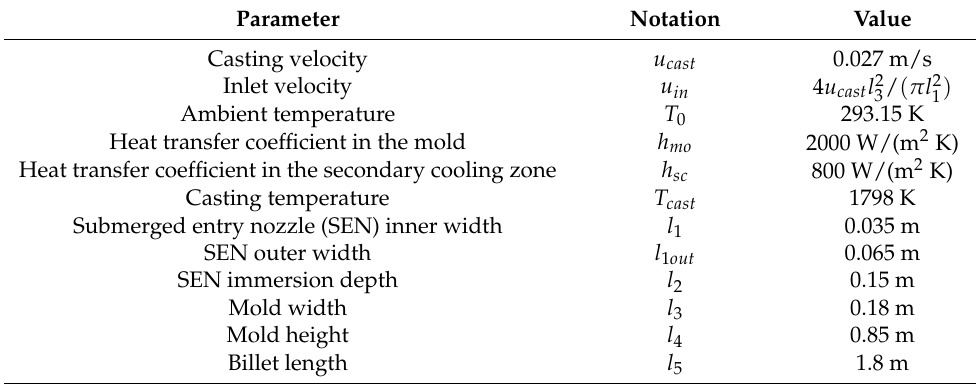
Table 1. Process parameters and billet domain